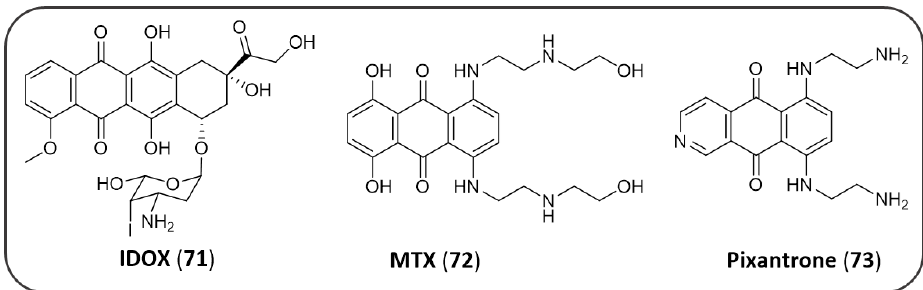
Figure 15. Representative AQ-containing molecules as agents for the treatment of AD.